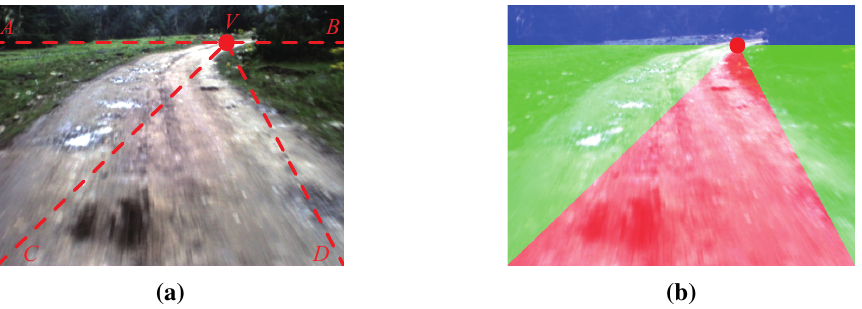
Figure 6. Clustering region: ( a ) illustration of the clustering region definition; ( b ) example of the clustering region definition.